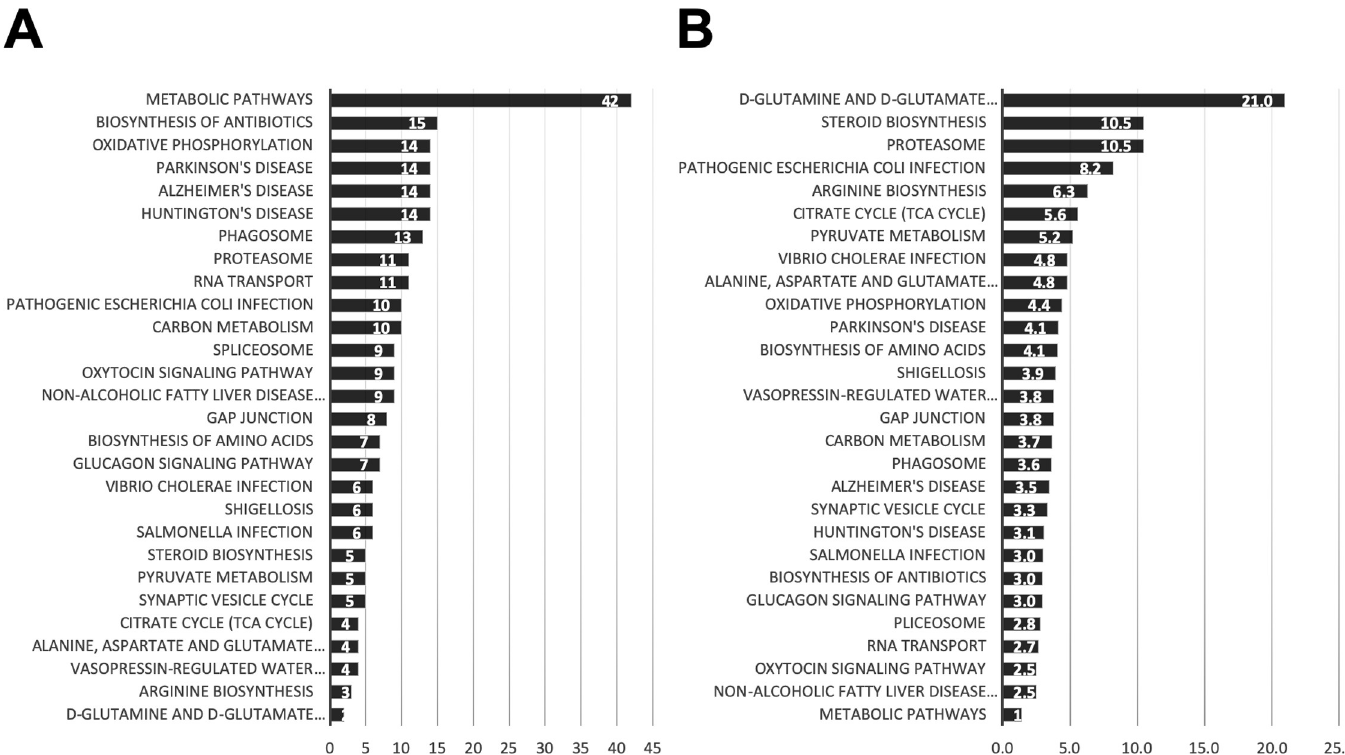
Fig 10. Hippocampus pathway enrichment analysis. Kyoto Encyclopedia of Genes and Genomes (KEGG) pathway enrichment analysis of swim genes of the HIP was performed using the Database for Annotation, Visualization and Integrated Discovery (DAVID). The gene count for each pathway is represented in A, whereas B represents the fold